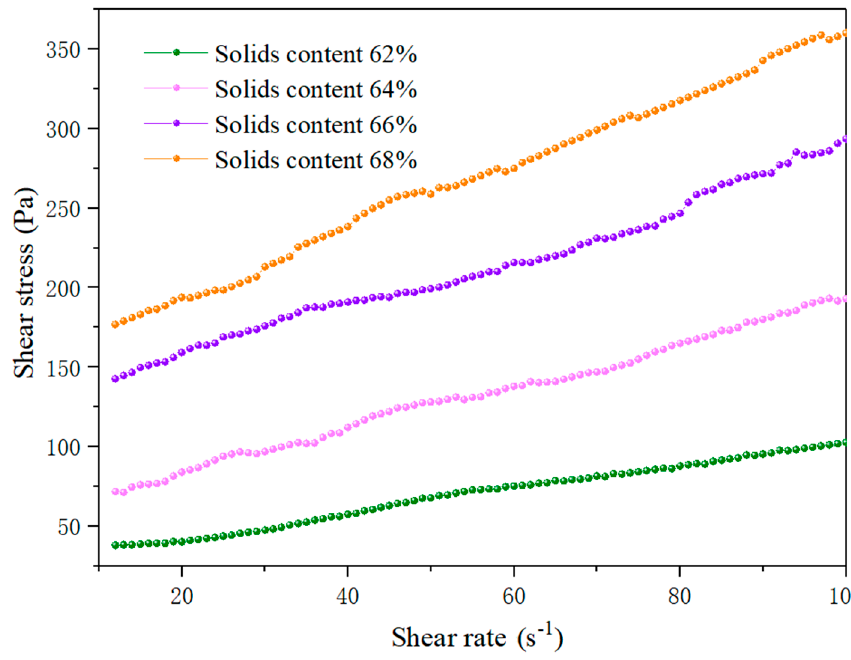
Figure 5. Shear rate versus shear stress flow curves of UCPB with ultrasonic wave action.